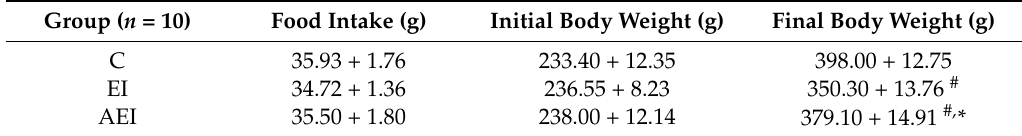
Table 3. Effects of aplysin on food intake and body